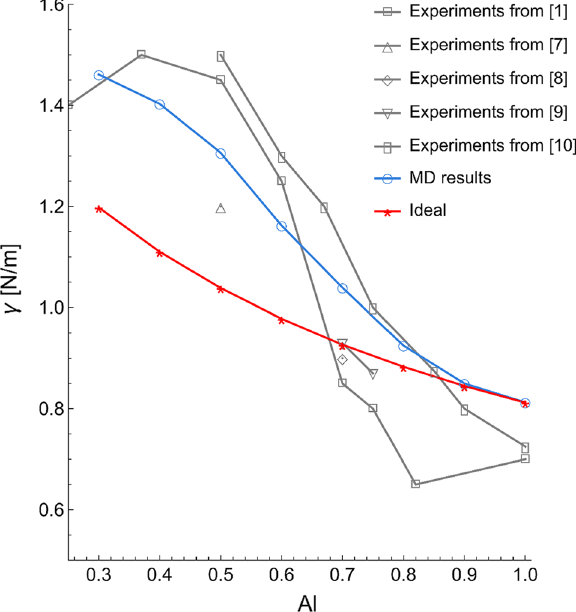
Figure 3. Comparison of surface tensions of Al–Ni alloys obtained using MD, the ideal solution model, and experiments (surface tension error bars were not presented since they were less than 0.05% of the absolute